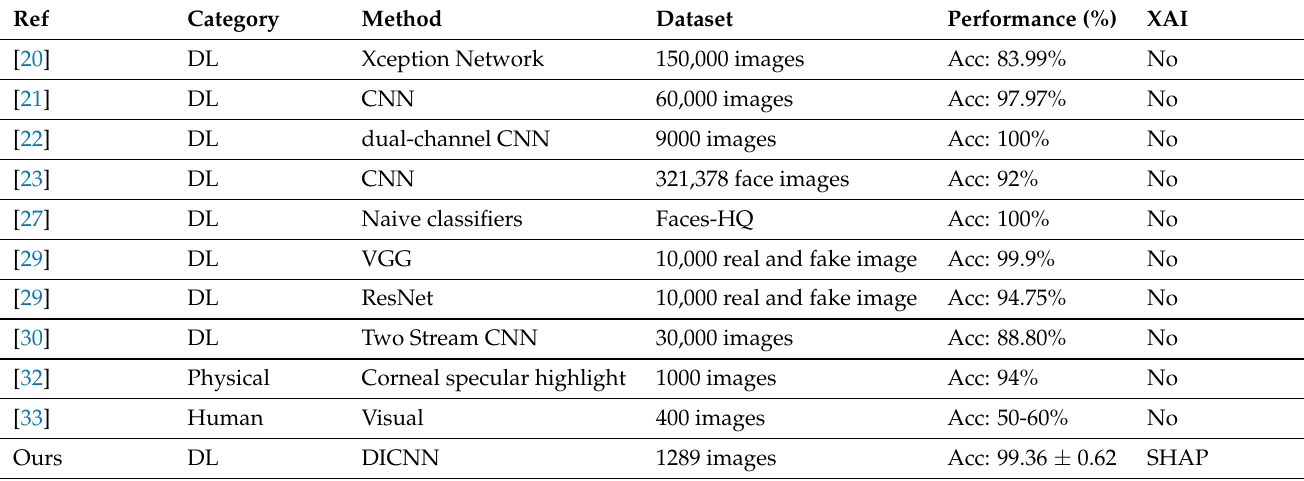
Table 4. Comparison of proposed DICNN model with other state-of-the-art methods. ’DL’ and ’Acc’ stand for deep learning and accuracy,